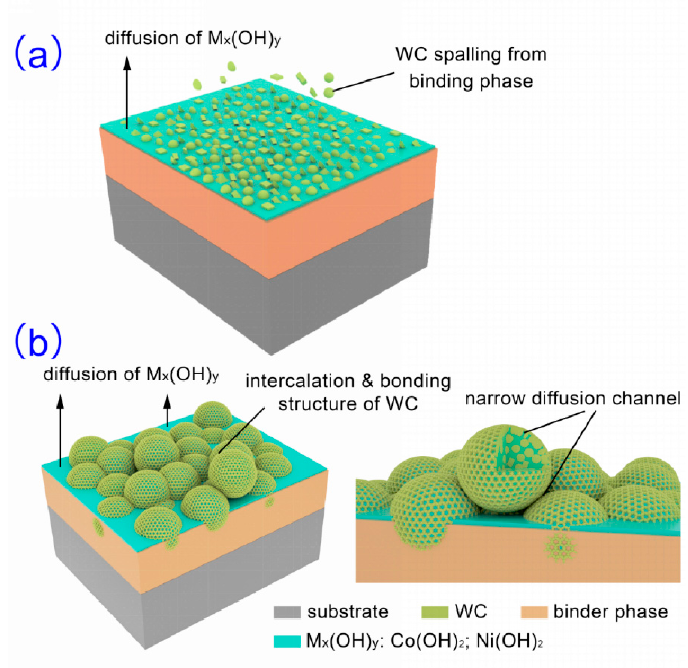
Figure 14. Diffusion model: ( a ) semi-infinite diffusion; ( b ) bounded diffusion.